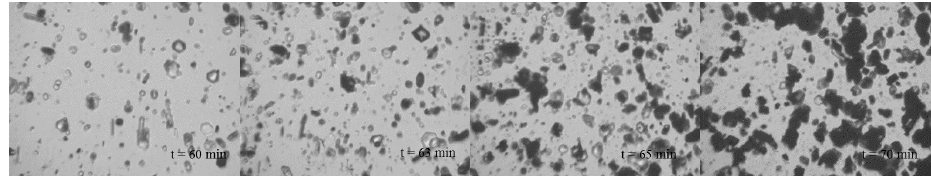
Figure 14. Real-time crystallization process images measured by the 2D imaging system (scale bar: 20 µ m).